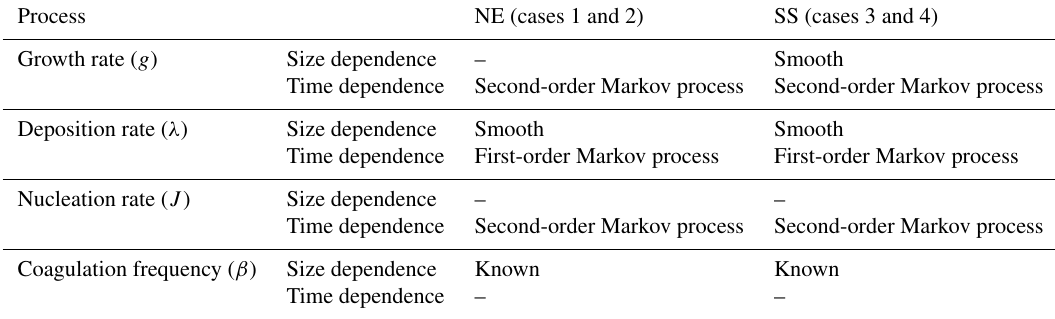
Table B1. Qualitative description of the models used in state estimation for nucleation event (NE) and steady-state (SS) cases. Process NE (cases 1 and 2) SS (cases 3 and 4) Growth rate ( g ) Size dependence – Smooth Time dependence Second-order Markov process Second-order Markov process Deposition rate ( λ ) Size dependence Smooth Smooth Time dependence First-order Markov process First-order Markov process Nucleation rate ( J ) Size dependence – – Time dependence Second-order Markov process Second-order Markov process Coagulation frequency ( β ) Size dependence Known Known Time